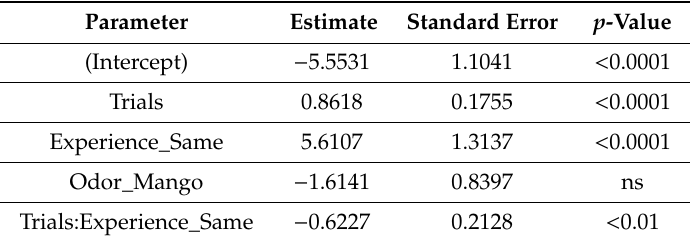
Figure 4. Probability of the conditioned response PER in the stingless bees, Melipona eburnean , on day 2. Bees that experienced the same odor the day before increased the conditioned response. The increment occurred along the trials, being higher when the conditioned odor was guava (G) than when it was mango (M) (model: Conditioned Response ~ Trials + Experience + Odor + (1 | Bee_Total) + Trials: Experience). The 95% confidence intervals are shown. Table 3. Comparative significance by levels of the main factors in the fitted model 2 (GLMM), explaining the olfactory conditioned response PER in day 2 of the stingless bee Melipona eburnea. ns: not significant.